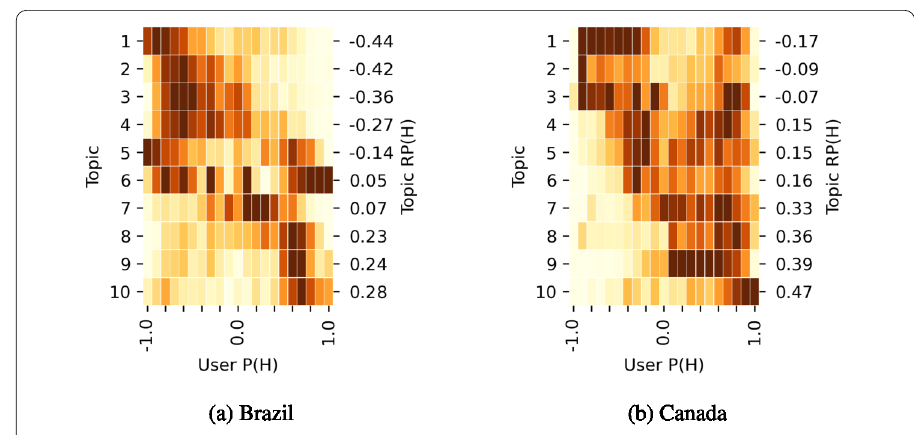
Figure 11 User engagement with topics - see Table 5 for data references